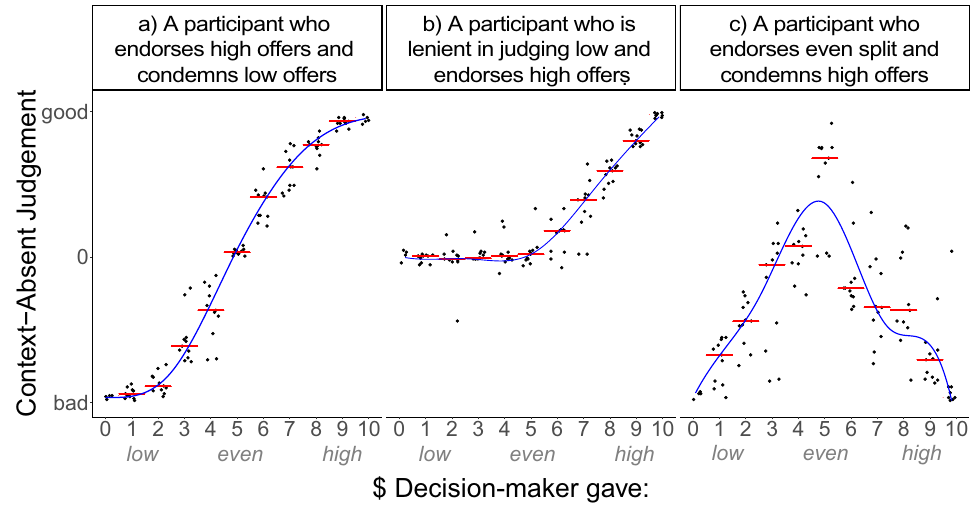
Figure 2. Context-absent judgement. Examples of three participants with different judgement styles. Judgement on each trial is plotted against the Decision-maker’s offer. Red bars represent the median judgement for the given offer. The blue line represents a smoothed functional data analysis fit over the median judgement